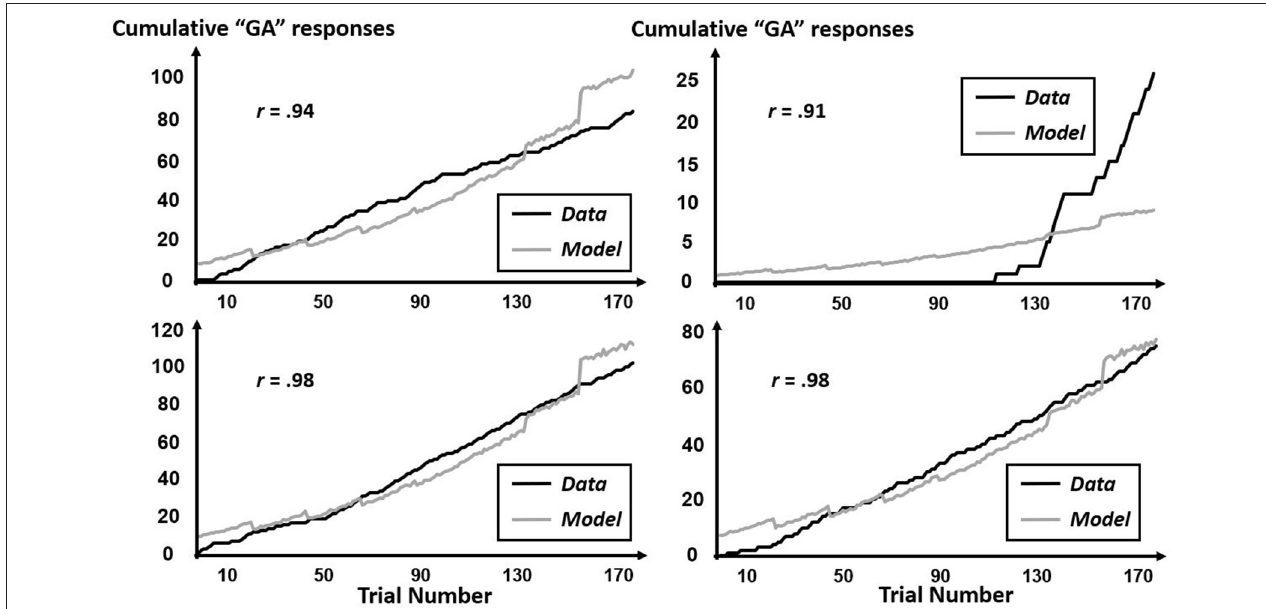
FIGURE 9 | Cumulative “GA” judgments and corresponding model predictions for four individual participants in the simulated-speech context. To depict the full range of regression-model performance in simulated-speech condition, we include individual-participant plots from the two participants for whose data the model fit worst (top two panels) as well as from the two participants for whose data the model fit best (bottom two